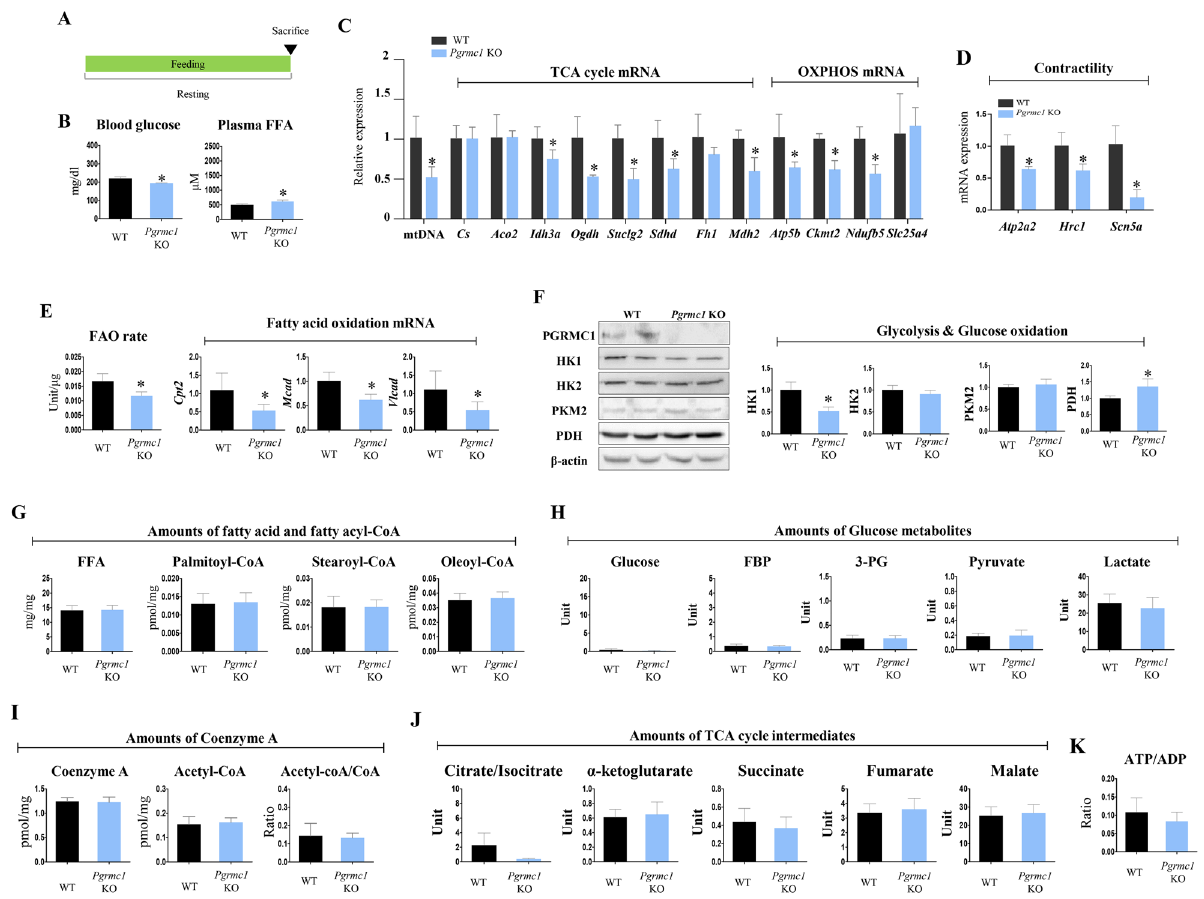
Figure 1. Pgrmc1 KO mice show low cardiac mitochondrial metabolism in resting state. ( A ) Schematic diagram which presents experimental schedule for resting state. ( B ) Levels of blood glucose (mg/dL) and plasma FFA (µM) in resting WT and Pgrmc1 KO mice. ( C ) Expression of mitochondrial DNA (mtDNA) in hearts of resting WT and Pgrmc1 KO mice. Nuclear DNA was used for an internal control. mRNA expression of TCA cycle and OXPHOS in hearts of resting WT and Pgrmc1 KO mice. Rplp0 was used for an internal control. ( D ) mRNA expression of contractility markers in hearts of resting WT and Pgrmc1 KO mice. Rplp0 was used for an internal control. ( E ) Fatty acid oxidation activity in hearts of resting WT and Pgrmc1 KO mice. mRNA expression of fatty acid oxidation genes in hearts of resting WT and Pgrmc1 KO mice. Rplp0 was used for an internal control. ( F ) Western blot analysis and quantification of glycolysis and glucose oxidation genes in hearts of resting WT and Pgrmc1 KO mice. β-actin was used for an internal control. ( G ) Cardiac FFA level (µM) and fatty acyl-CoA levels (pmol/mg) in resting WT and Pgrmc1 KO mice. ( H ) Levels of glucose metabolites (unit) in resting WT and Pgrmc1 KO mice. ( I ) Levels of coenzyme A (CoA) and acetyl-CoA in resting WT and Pgrmc1 KO mice. ( J ) Levels of TCA cycle intermediates in resting WT and Pgrmc1 KO mice. ( K ) Ratio of ATP per ADP in resting WT and Pgrmc1 KO mice. Values represent means ± SD. *p < 0.05. Student’s t test was performed. Total numbers of mice used for experiment were 5 (control WT), 4 (control Pgrmc1 metabolism in mitochondrial defective Pgrmc1 KO mice, we induced HFD conditions as shown in Fig. 3A. Under these conditions, blood glucose level was decreased (p < 0.05, 67.2% vs. HFD WT), while plasma FFA levels were increased (p < 0.05, 1.33-fold vs. HFD WT) in HFD Pgrmc1 KO mice (Fig. 3B). The expression of mtDNA was decreased (p < 0.05, 54.5% vs. HFD WT) in the hearts of HFD Pgrmc1 KO mice (Fig. 3C). mRNA expression of TCA cycle genes, Cs , Ogdh , Suclg2 , and Mdh2 (p < 0.05, 28.8, 47.8, 45,7, and 64.1%, respectively, vs. HFD WT), and OXPHOS genes, Atp5b , Ckmt2 , and Ndufb5 (p < 0.05, 52.3, 60, and 69%, respectively, vs. HFD WT), were suppressed in the hearts of HFD Pgrmc1 KO mice (Fig. 3C). mRNA expression of Atp2a2 , Hrc1 , and Scn5a was decreased (p < 0.05, 41.2, 42, and 34.7%, respectively, vs. HFD WT) in HFD Pgrmc1 KO hearts (Fig. 3D). Fatty acid oxidation activity was significantly lower (p < 0.05, 75.9% vs. HFD WT) in the hearts of HFD Pgrmc1 KO mice (Fig. 3E). Expression of mRNAs of fatty acid oxidation genes, Cpt2 , Mcad , and Vlcad , was suppressed (p < 0.05, 44.7, 53.1, and 43.1%, respectively, vs. HFD WT) in the hearts of HFD Pgrmc1 KO mice (Fig. 3E). Pro- tein expression of glycolysis and glucose oxidation genes, HK1, HK2, PKM2, and PDH, was increased (p < 0.05, 1.99-, 2.26-, 1.62-, and 1.65-fold, respectively, vs. HFD WT) in the hearts of HFD Pgrmc1 KO mice (Fig. 3F). Levels of metabolites showed a more pronounced difference in HFD Pgrmc1 KO hearts. Levels of palmi- toyl-CoA, stearoyl-CoA (C18:0), and oleoyl-CoA (C18:1) were increased (p < 0.05, 2.04-, 1.28-, and 1.6-fold,